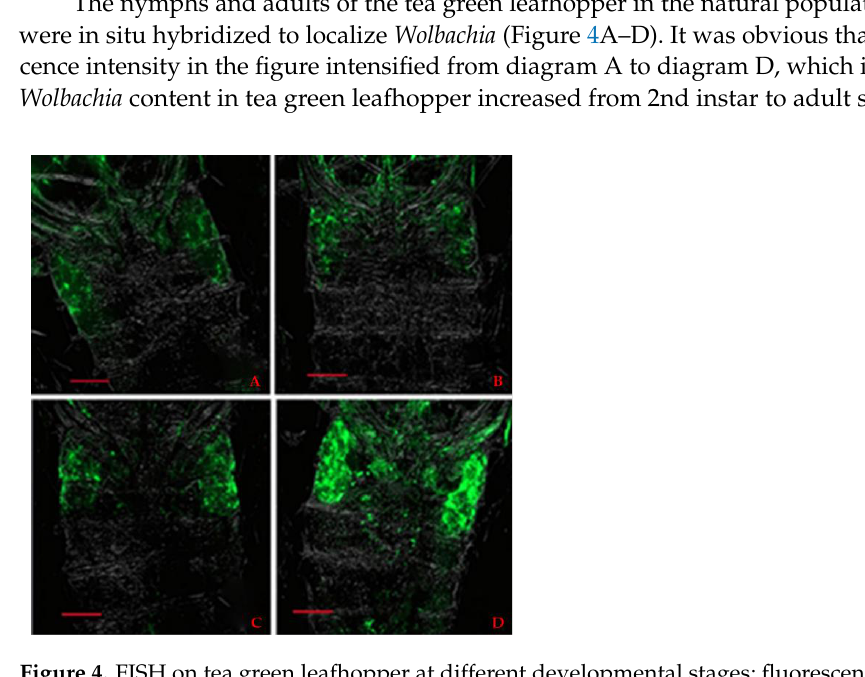
Figure 4. FISH on tea green leafhopper at different developmental stages; fluorescence illustration refers: ( A ) 2nd instar), ( B ) 4th instar, ( C ) 5th instar, ( D ) adult 5 days. (Red scale bar = 1 mm).